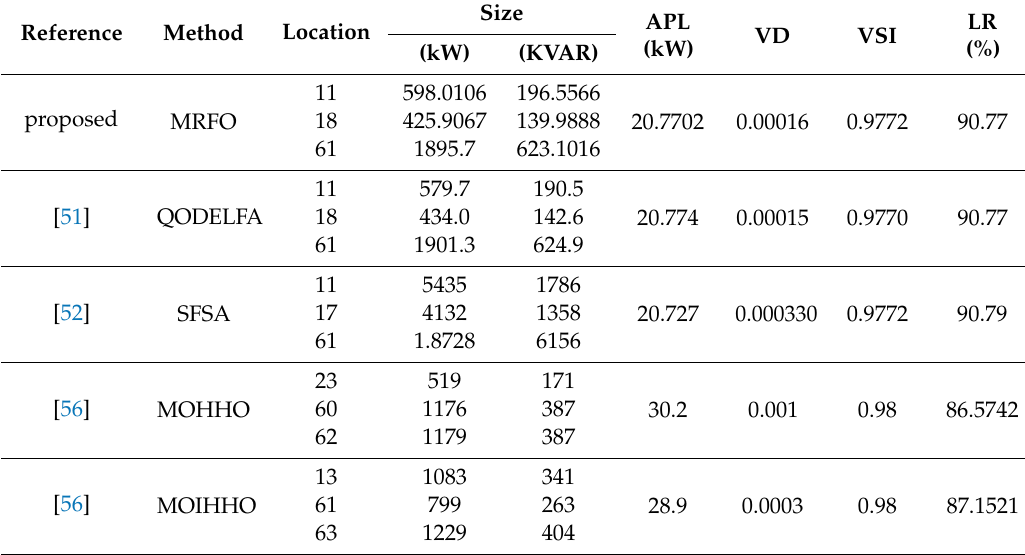
Table 7. 69-bus, three DG units at 0.95 lag pf.